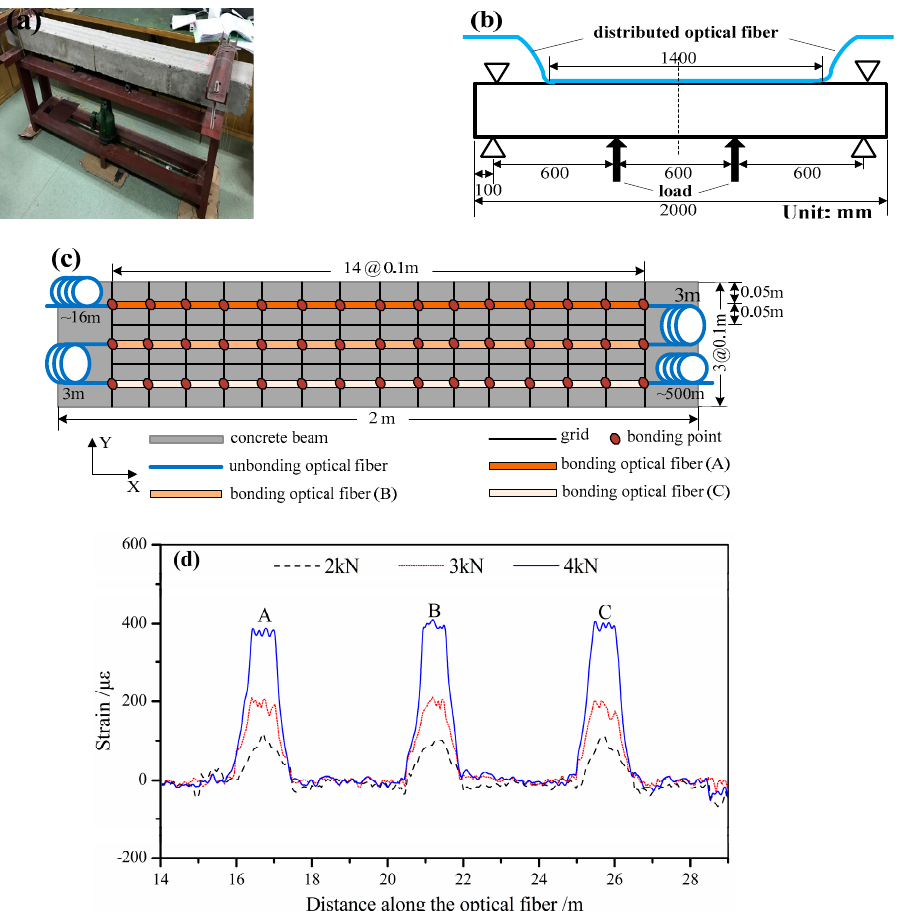
Figure 12. Measurement of the strain distribution in the frame beam: ( a ) the test setup; ( b ) the dimensions of the test setup; ( c ) the layout of the distributed optical fiber sensor; ( d ) the measurement results of the surface strain on the frame beam.